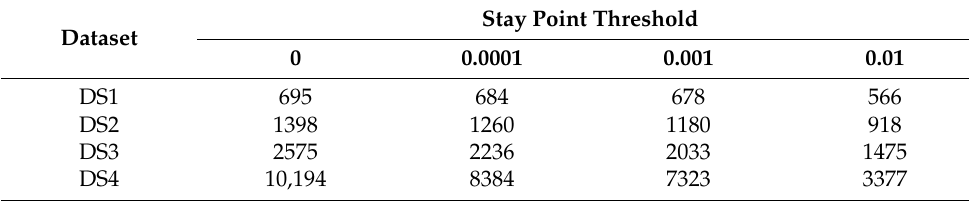
Table 3. Retained sampling points after